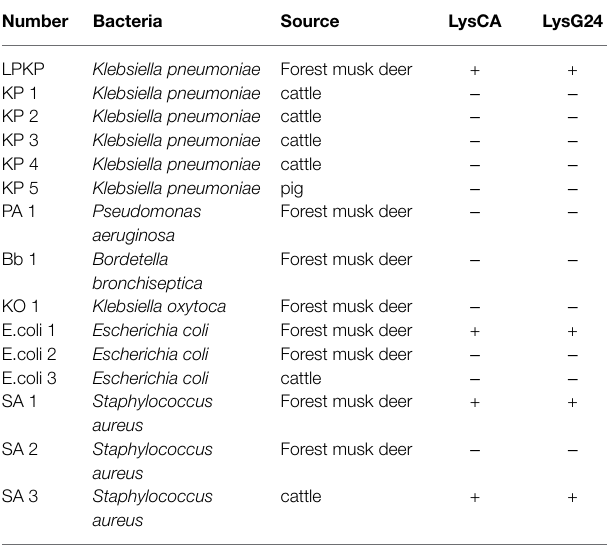
TABLE 4 | Lysis profile of LysG24 and